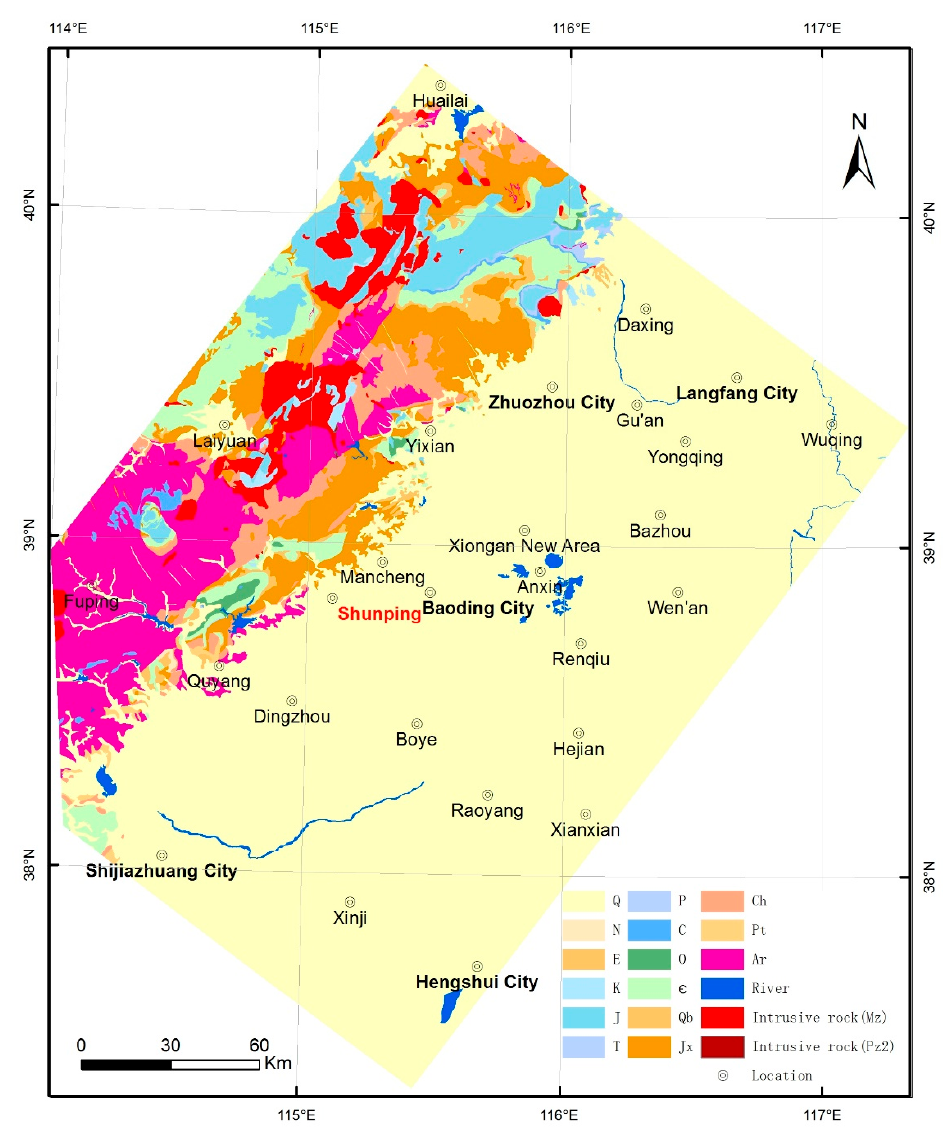
Figure 1. Regional geological map.